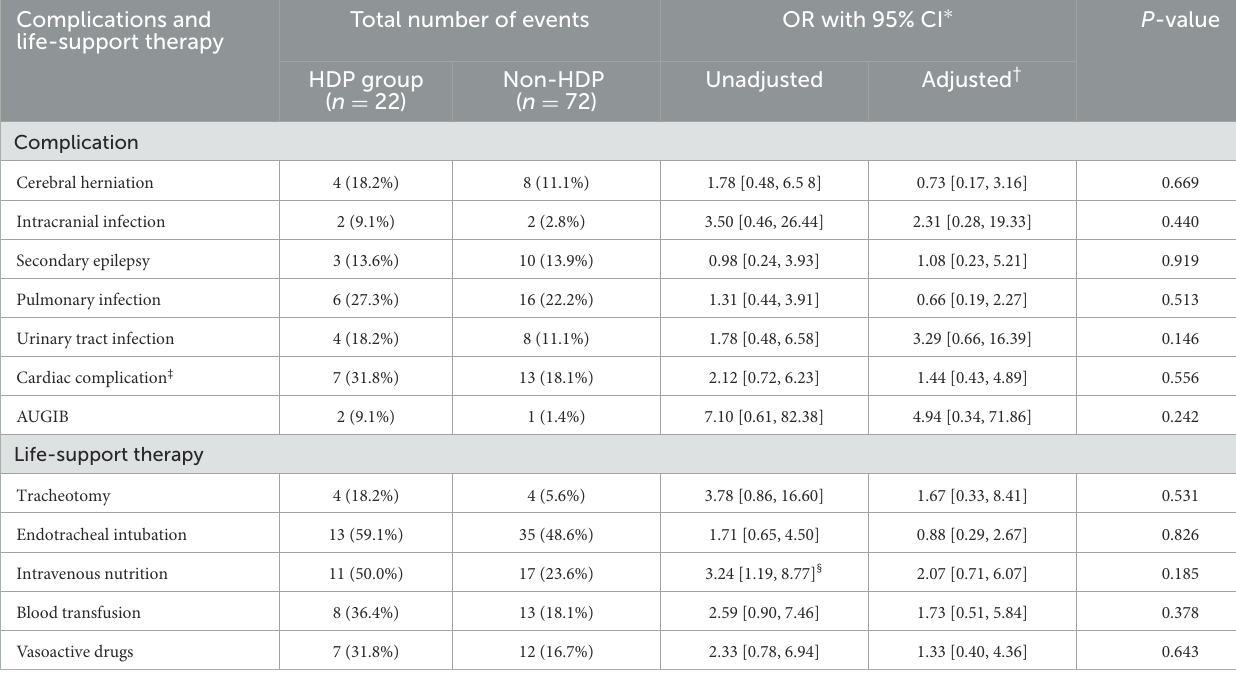
TABLE 4 Odds ratios (ORs) with confidence interval (CI) ∗ for complications and life-support therapy by hypertensive disorders of pregnancy (HDP) status among hemorrhagic stroke related to pregnancy. Complications and life-support therapy